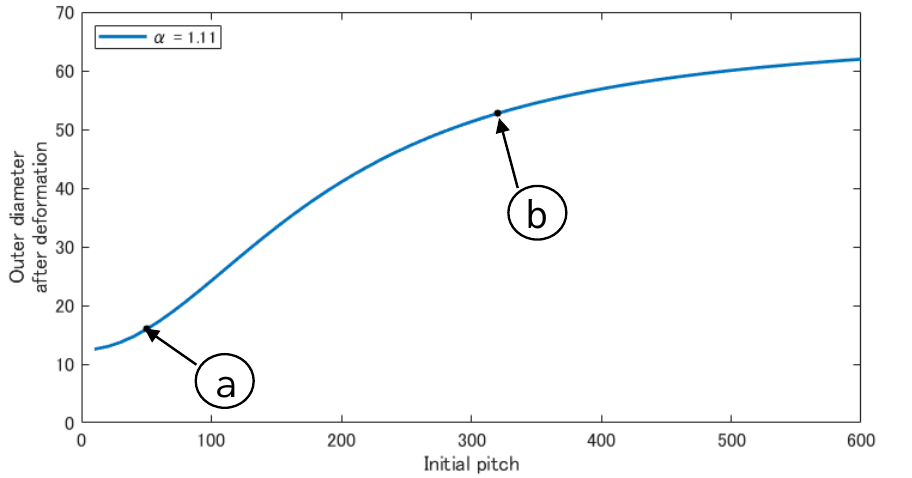
Figure 5. Relationship between the initial pitch and the outer diameter after deformation when α =